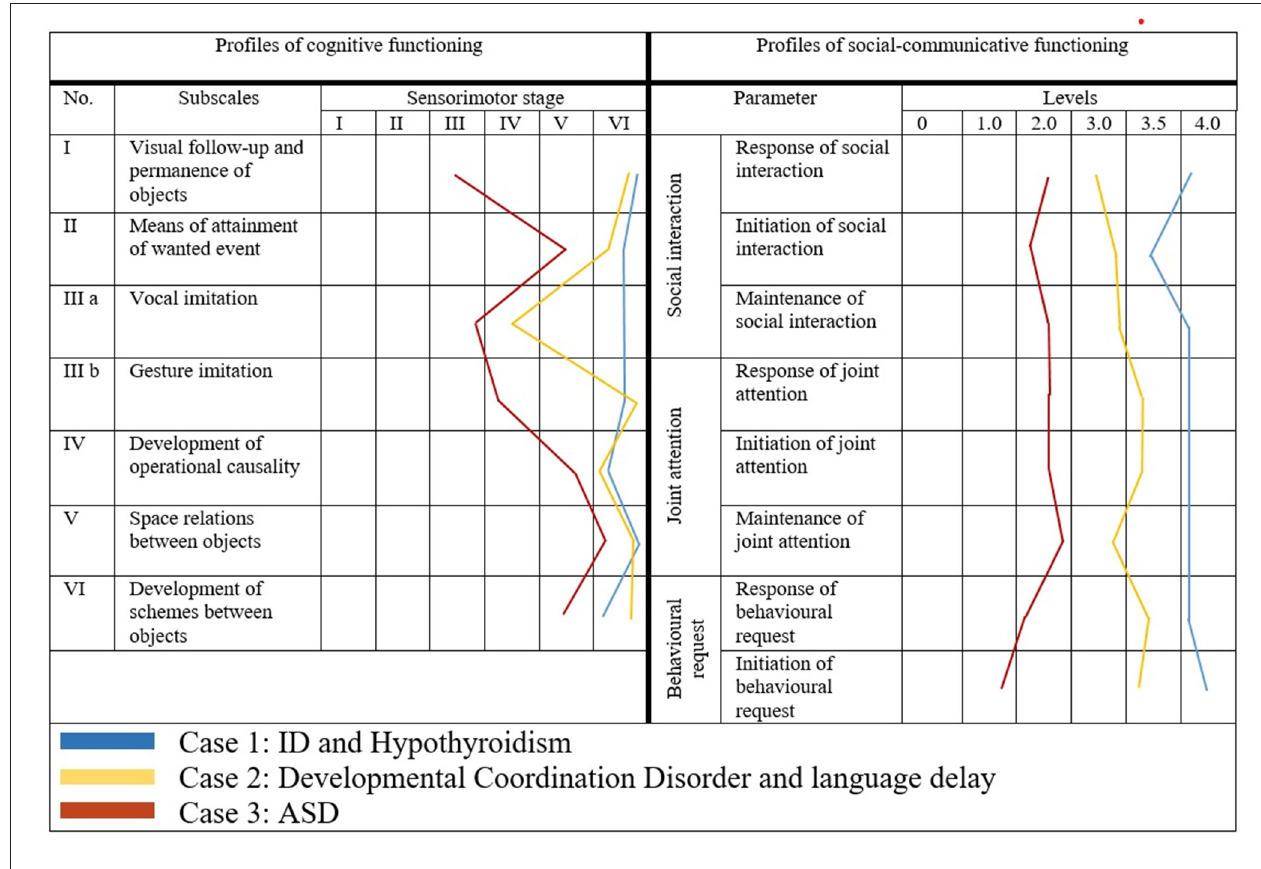
FIGURE 1 | Profiles of psychological development of children with ASD and other neurodevelopmental